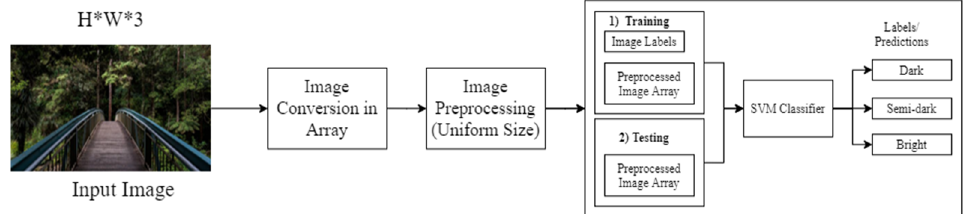
Figure 7. Support Vector Machine (SVM) Classification Pipeline.